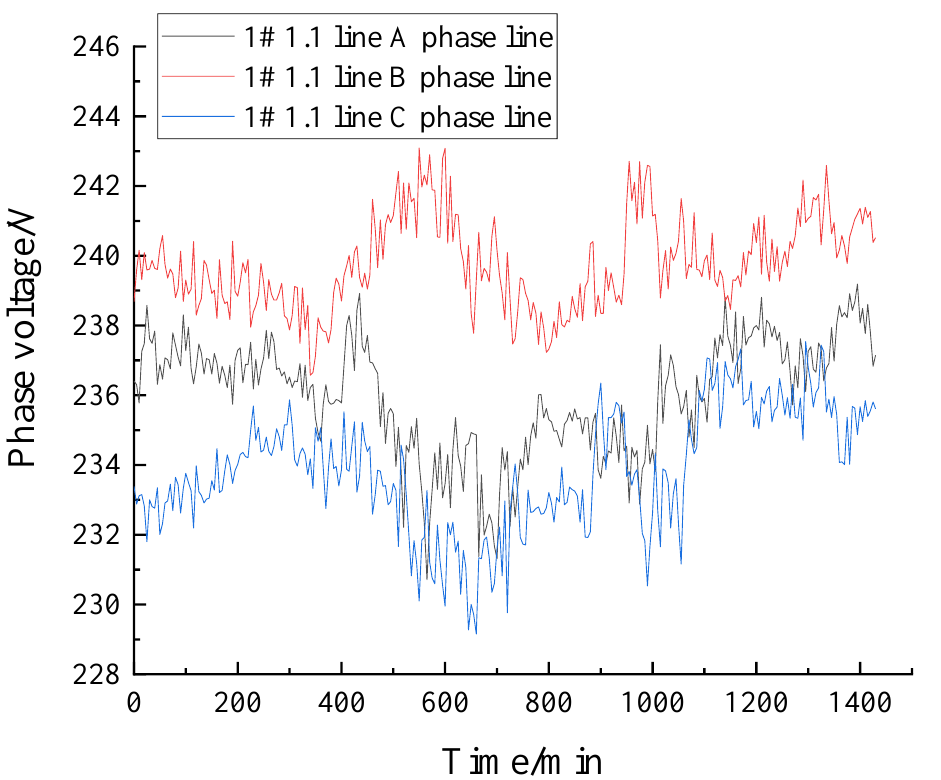
Figure 5. Voltage distribution circuit of different phase lines at the same point in station area.